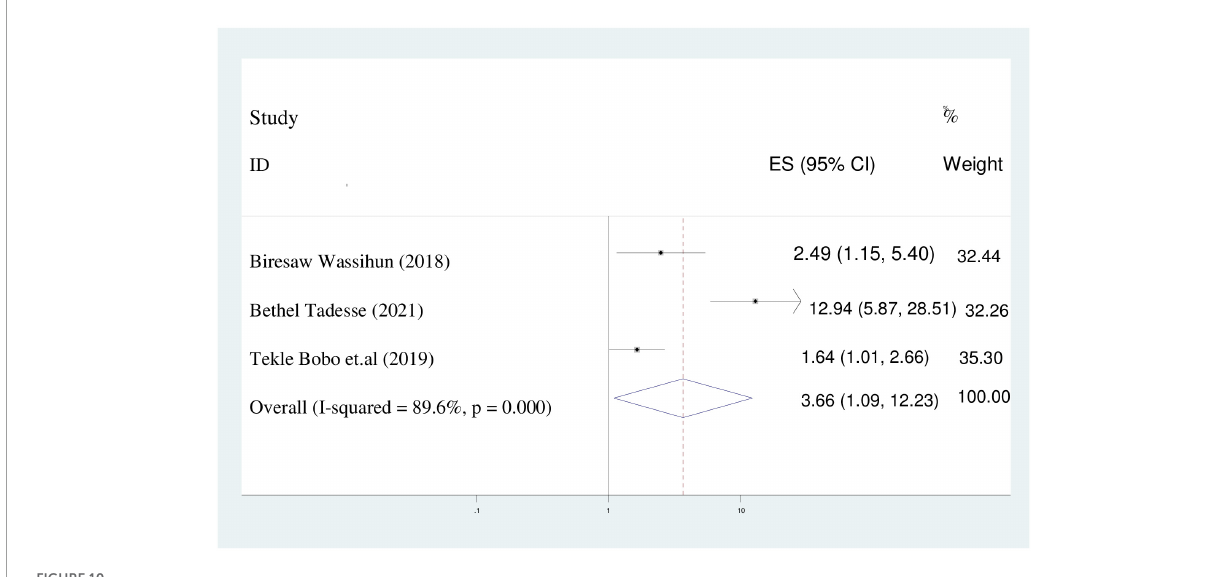
FIGURE10 Pooled odds ratio displaying the association of receiving care at government hospitals with disrespect and abuse of women.